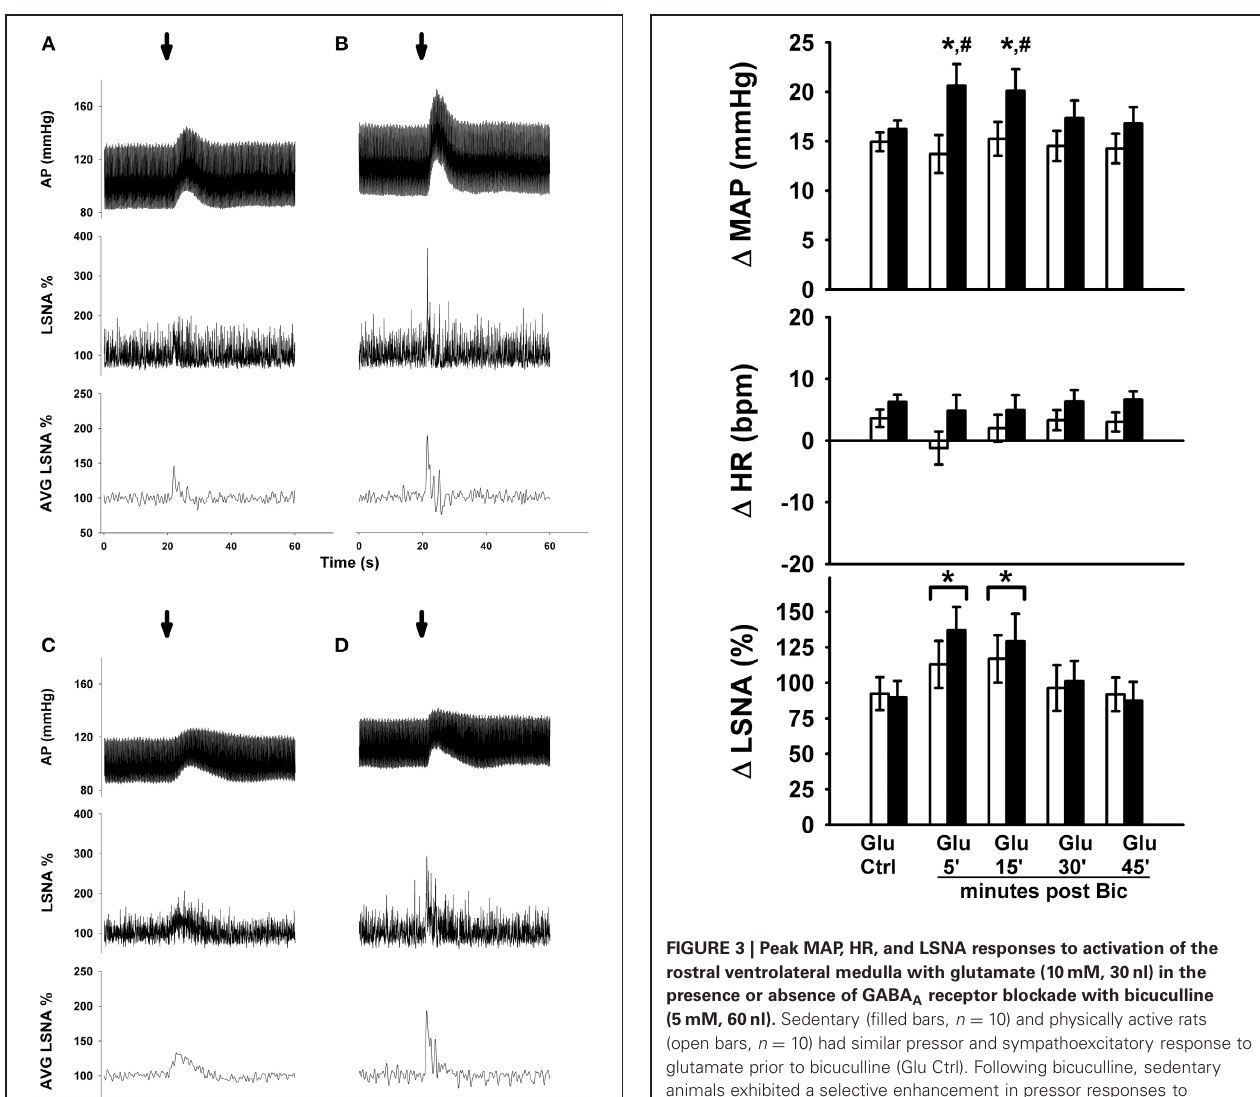
and LSNA to microinjections of glutamate (30 nl, 10 mM)